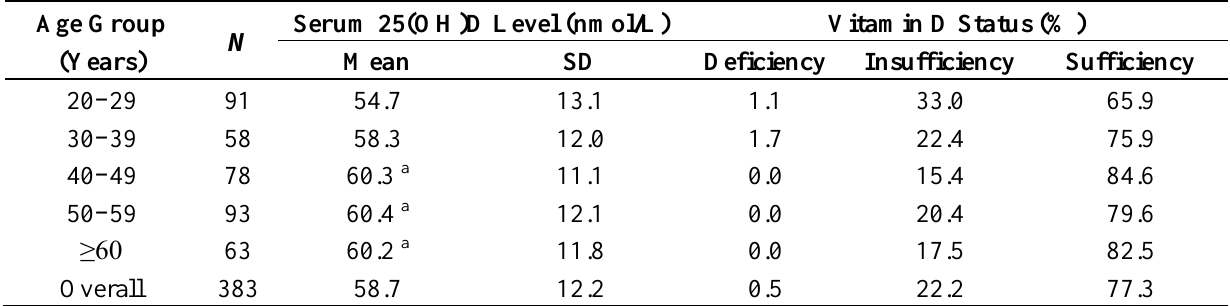
Table 3. Serum 25(OH)D level and vitamin D status of the subjects in each age group.